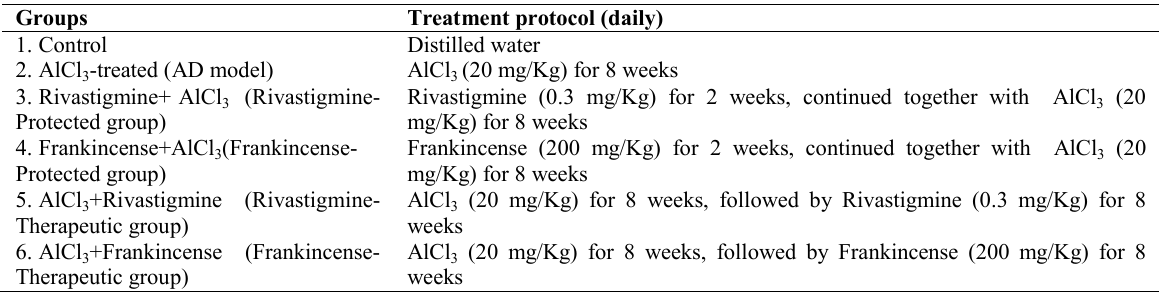
Table 1. Daily treatment protocol of each separate group of